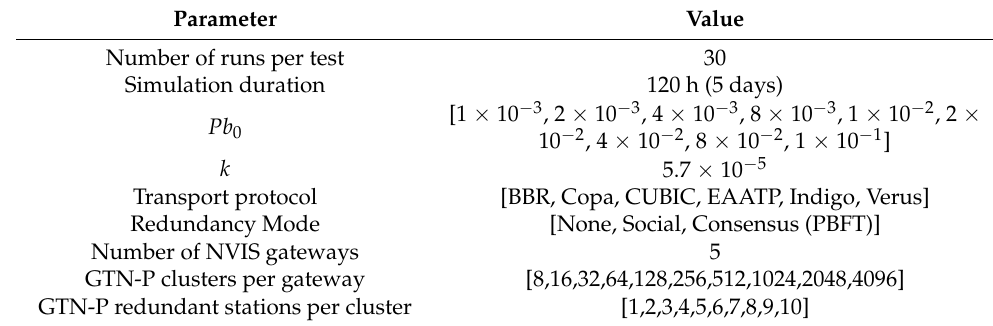
Table 2. Simulation